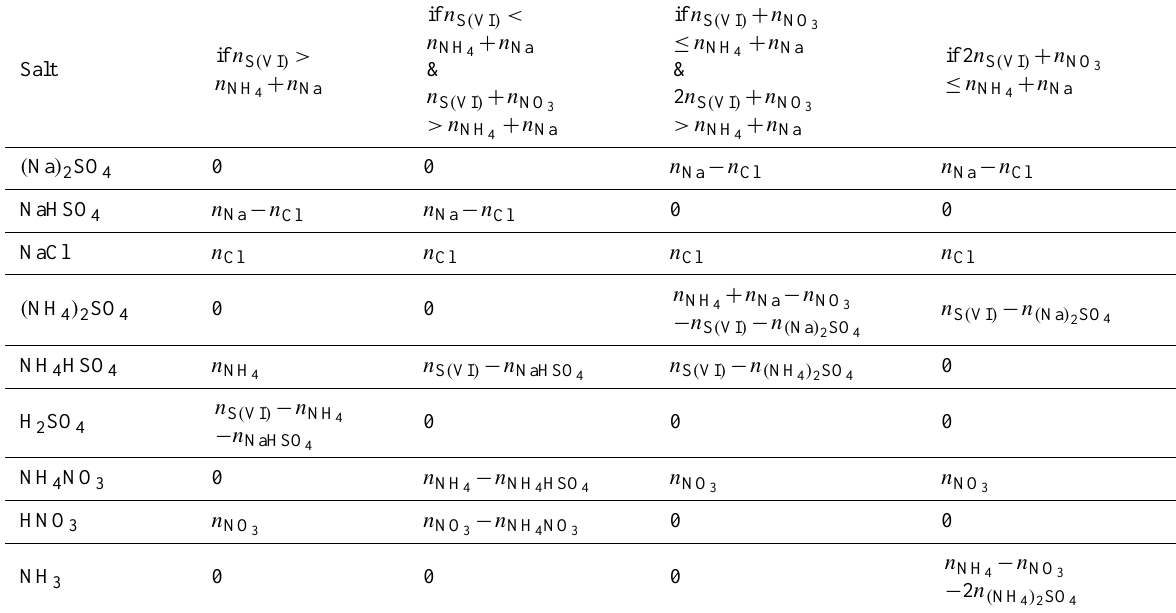
Table E. Explicit scheme used to estimate the particle salt molar